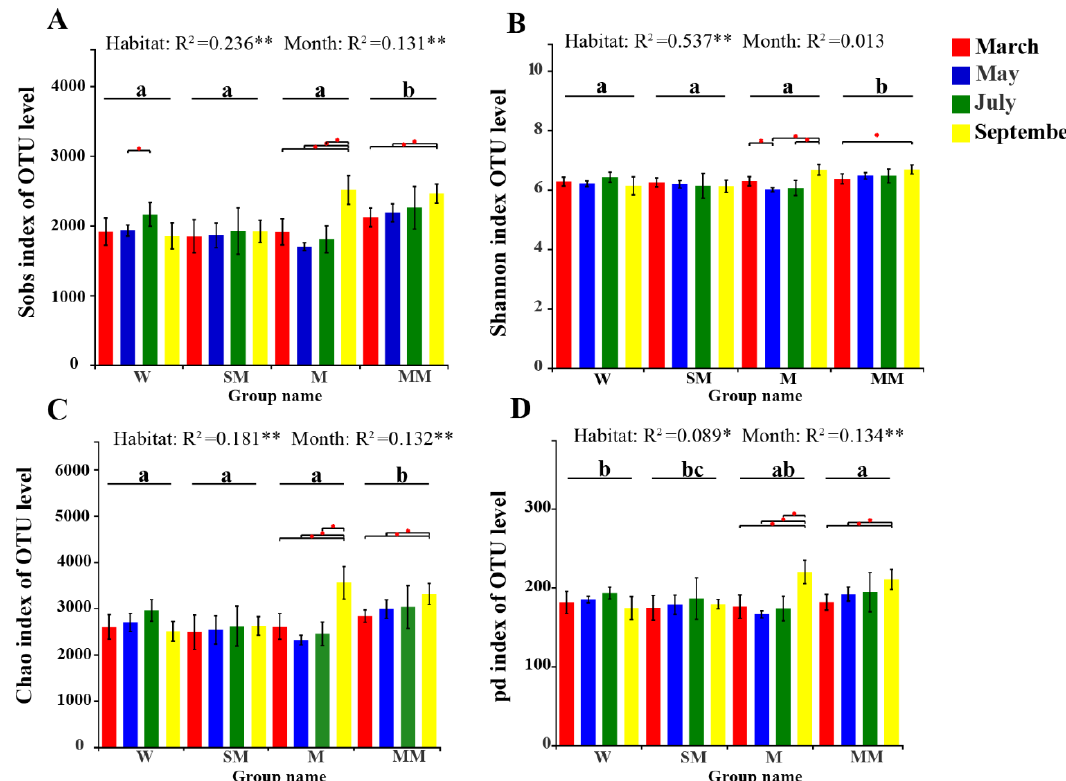
Figure 2. Estimated values of bacterial community Sobs index ( A ), Shannon index ( B ), Chao 1 index ( C ) and phylogenetic diversity ( D ). Significant differences are indicated by different letters. Significant differences among months in each habitat are marked by stars (** p < 0.01; * p < 0.05). The letters of “a”, “b” and “c” in the figure represent the post-hoc results following ANOVA analyses. Significant differences between different habitats are marked by different letters. SW is swamp wetland, SM is swamp meadow, M is meadow, MM is mature meadow.